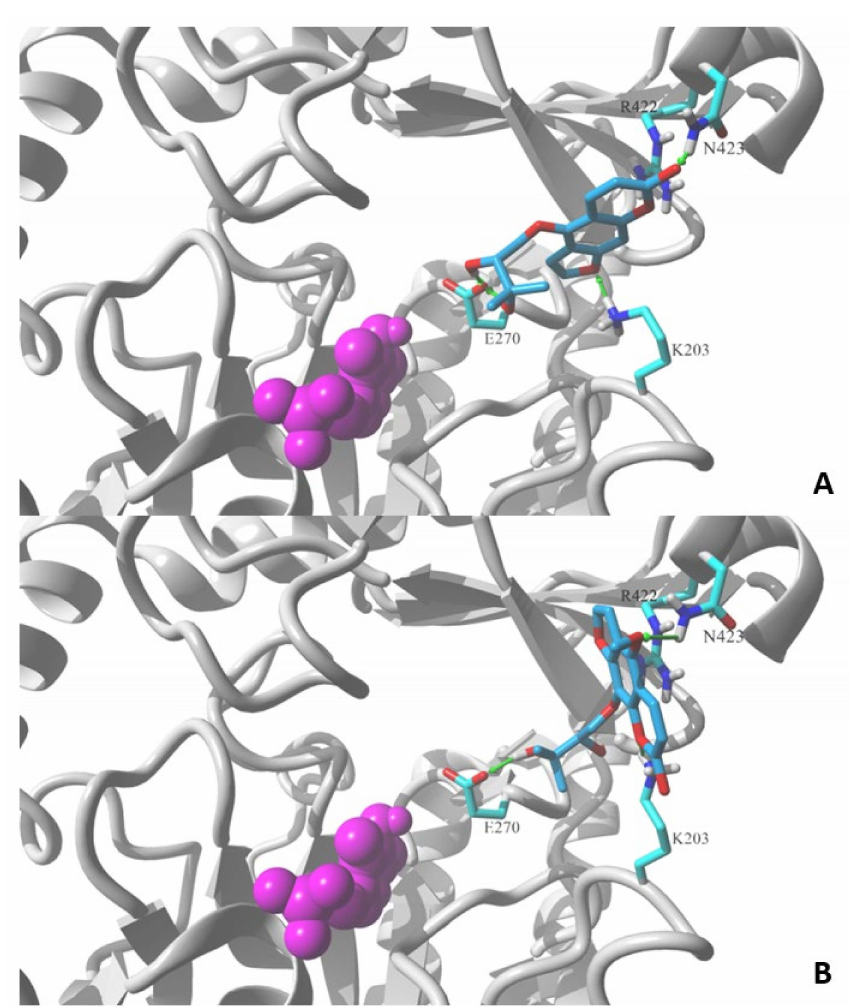
Figure 4. Lowest energy poses of ( A ) oxypeucedanin hydrate (2) and ( B ) byacangelicin (8) docked to a structural model of GABA-transaminase cocrystalized with pyridoxal 5 (cid:48) -phosphate (1OHV.pdb). Docked molecules are rendered in stick mode with atom color coded style; protein molecule is rendered in secondary structure mode (gray) and only the residues found essential for interaction with docked molecules are explicitly visualized in the stick model (discussed hydrogen bonds shown as green arrows). Pyridoxal 5 (cid:48) -phosphate cofactor molecule is shown in ball mode and colored in magenta. All aliphatic hydrogen atoms are hidden for clarity. Figures prepared in YASARA